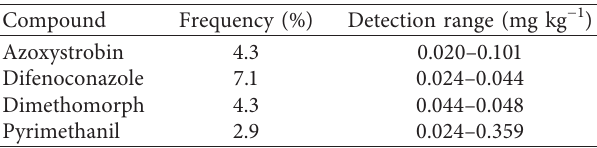
Table 3: Pesticide detected in real samples of ginseng ( n � 70) using the developed